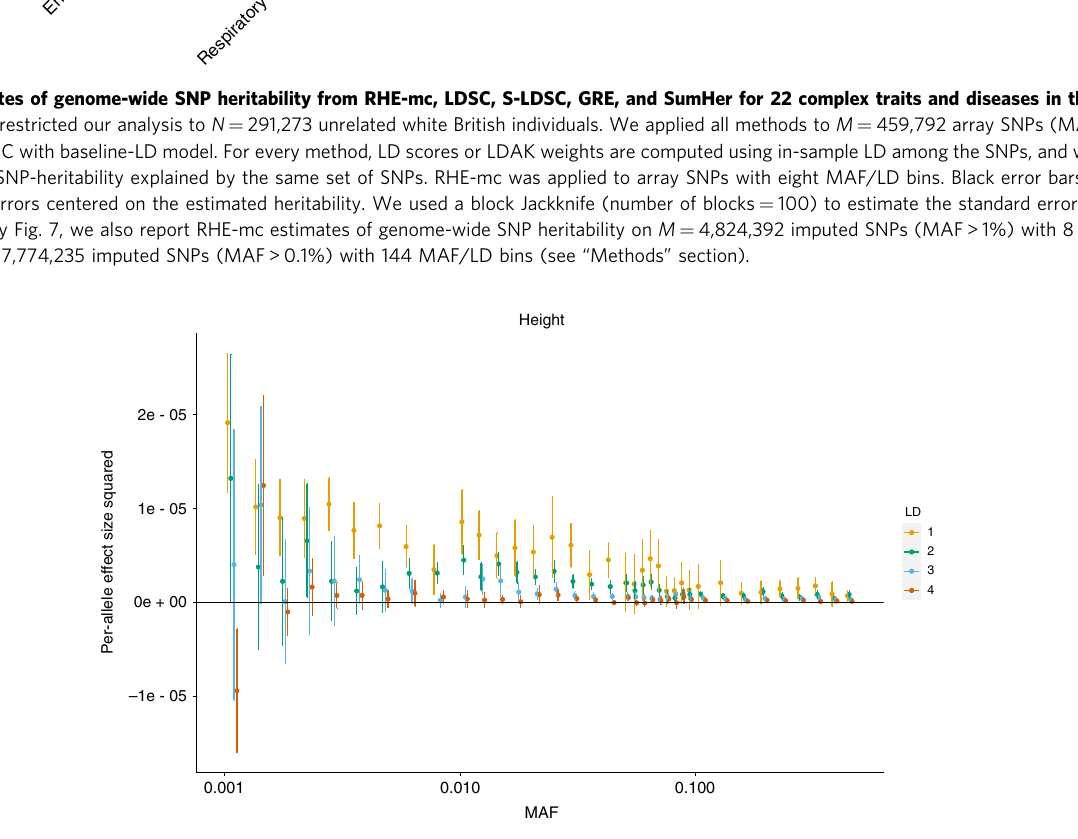
, where h 2 k is the heritability attributed to k (cid:1) 2 f k (cid:1)ð 1 (cid:3) f k Þ